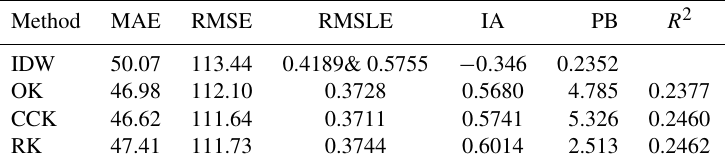
Table 4. The 5 × 10-fold cross-validation results.